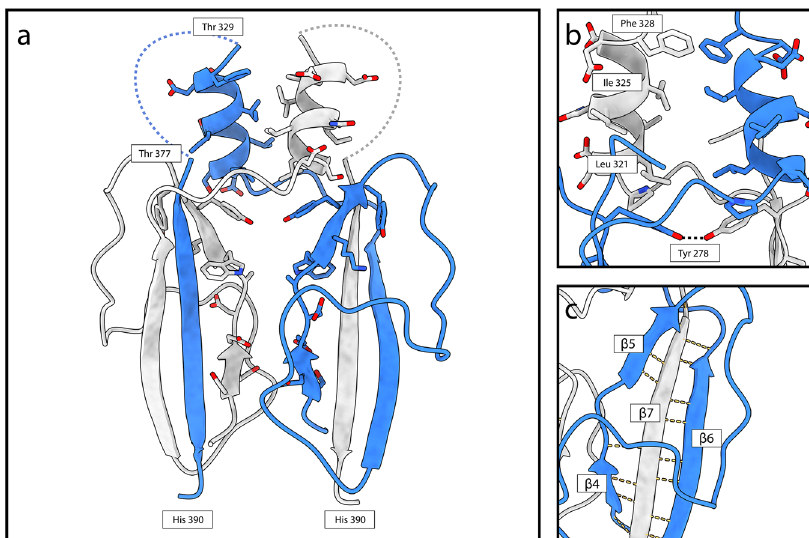
Fig. 2 The PCV-1 protrusion domain forms the homodimer interface. a The PCV-1 P domain shown in cartoon form, residues close to the interface are shown in stick form. Dashed lines denote the regions occupied by the hypervariable loop for which there is no density. b α 7 from each subunit form a hydrophobic interface at the tip of the P domain. c β 7 from each subunit swaps into the opposing P domain forming an extended hydrogen bond network in a 3-standed β